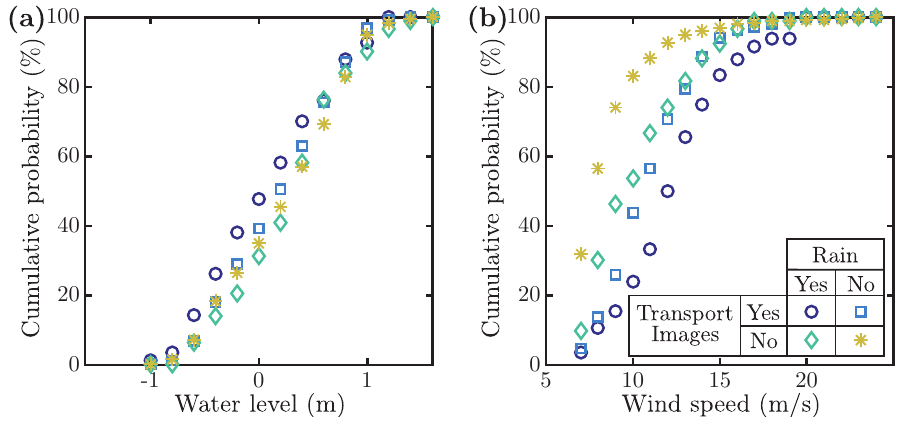
Figure 16. Cumulative distribution of water levels ( a ) and wind speeds ( b ) during hours in which transport or no transport was observed in the images, when U (cid:62) U Threshold = 7 m/s considering onshore wind conditions and its relationship with the presence or absence of rain during the same hour. Table 7. Average water level (m above NAP) in which transport or no transport was observed in the images, when U (cid:62) U Threshold considering onshore wind conditions and its relationship with the presence or absence of rain during the same hour. Where U Threshold Onshore = 7 m/s corresponds to the minimum hourly wind speed at which transport was observed in the images. Rain Yes No Transport Yes 0.07 0.17 Images No 0.26